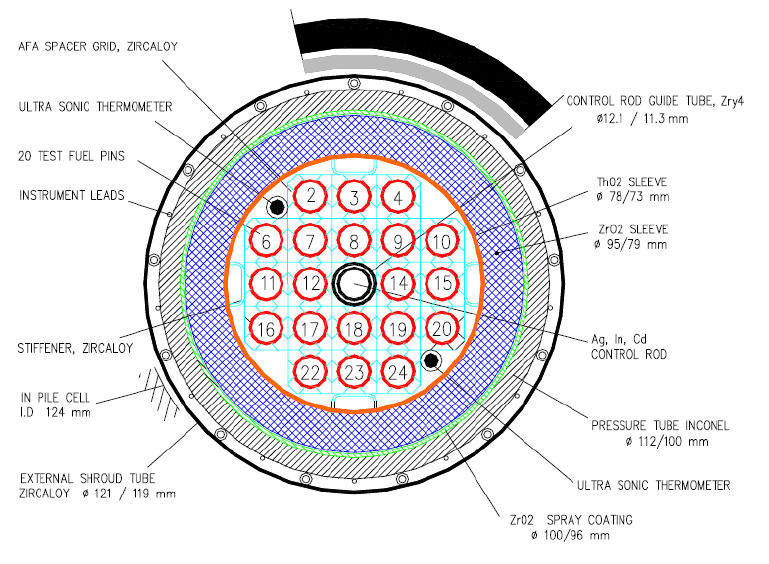
Figure 2. Radial cross-section of the FPT-1 test bundle [11].